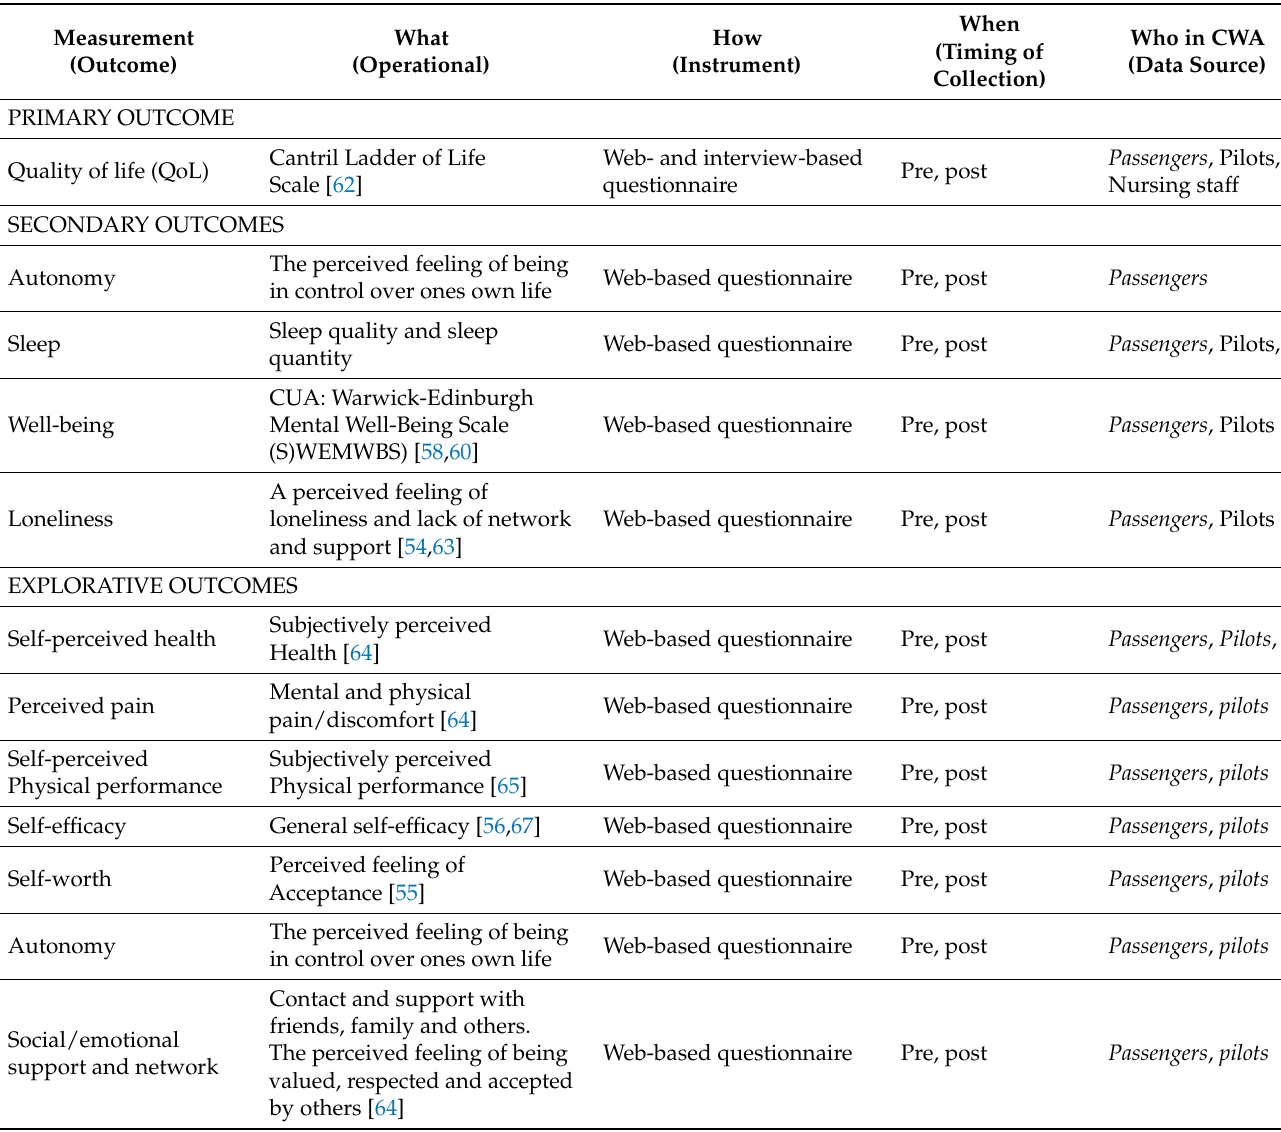
Table 3. Outcome and measures in the Cycling Without Age